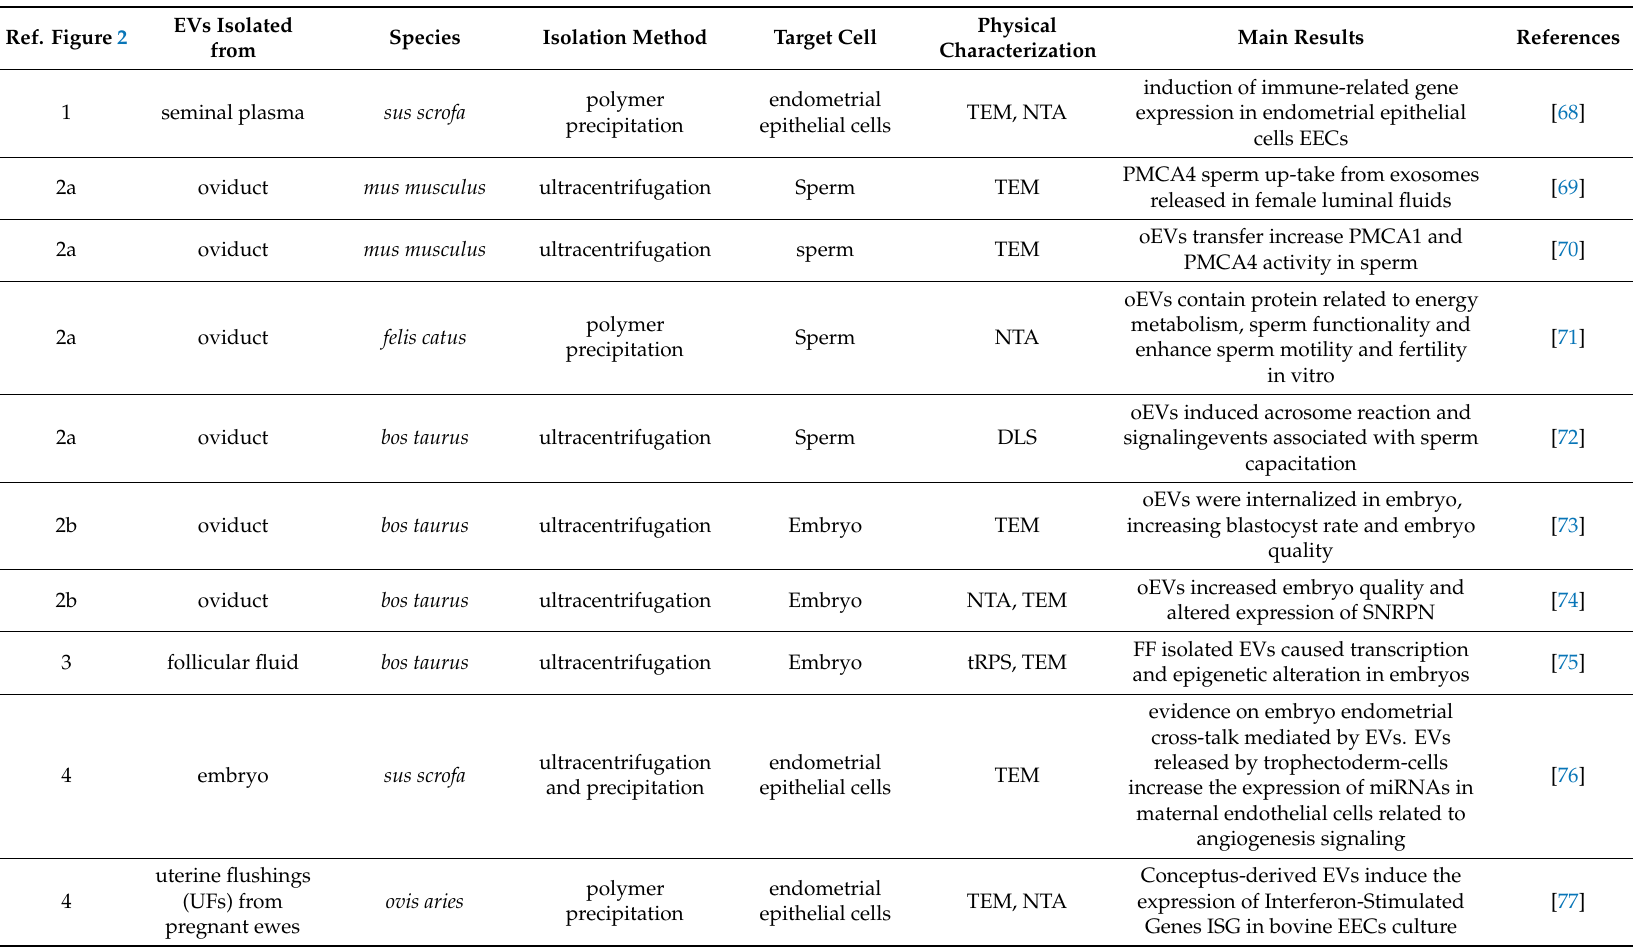
Table 2. Extracellular vesicles mediated cross-talk between di ff erent compartments of the reproductive system as shown in Figure 2. Extracellular vesicles released from di ff erent cell or body fluids (seminal plasma, oviduct, follicular fluid, embryo, placental mesenchymal stem cells, endometrial epithelial cells) and from di ff erent species ( bos taurus , felis catus , homo sapiens, mus musculus , ovis aries , sus scrofa ), target di ff erent cell types. Method of isolation, main results and references for each EV-mediated exchange are also